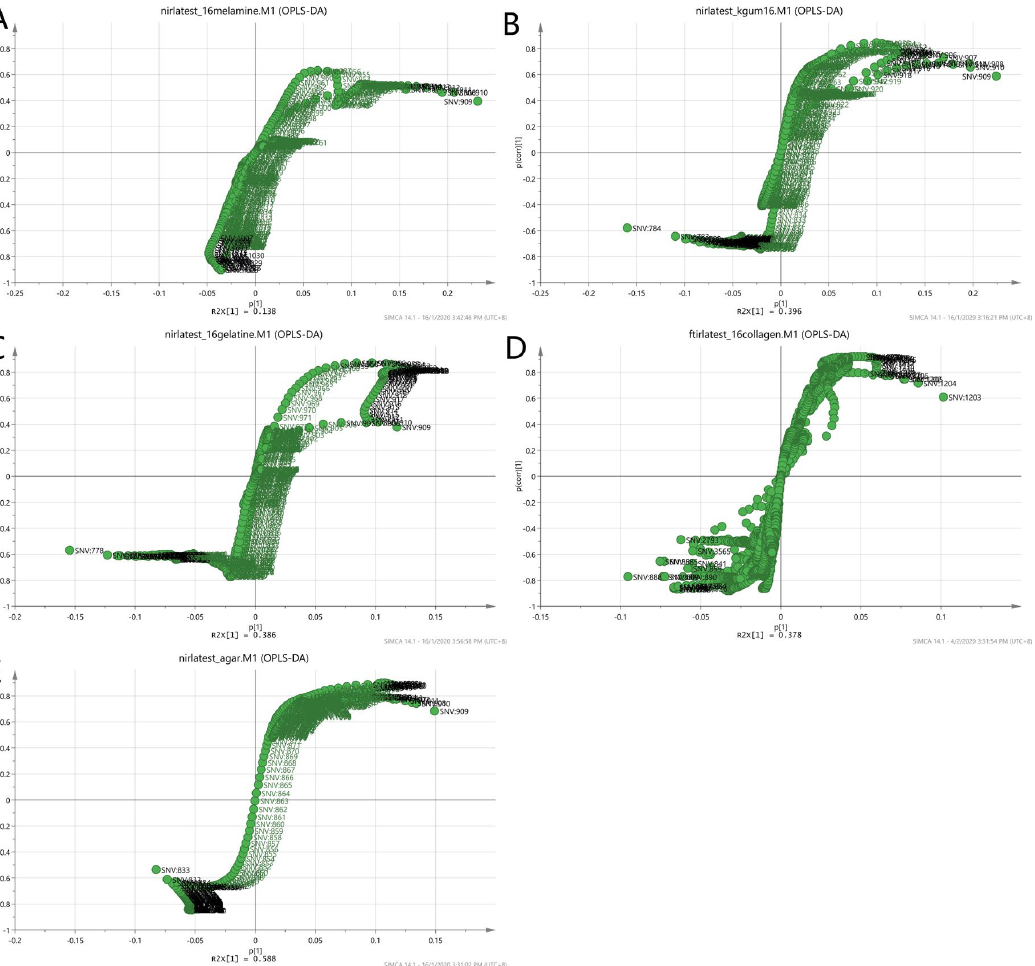
Figure 10. Loading S-plot of a two-class OPLS-DA model for authentic and non-authentic classes using VIS/SW-NIR spectra (( A ) melamine, ( B ) karaya gum, ( C ) gelatine, ( D ) collagen and ( E ) nutrient agar) The number represents the wavelength of the VIS/SW-NIR spectra, which is the significant factor that contributed to the discrimination of the two classes .